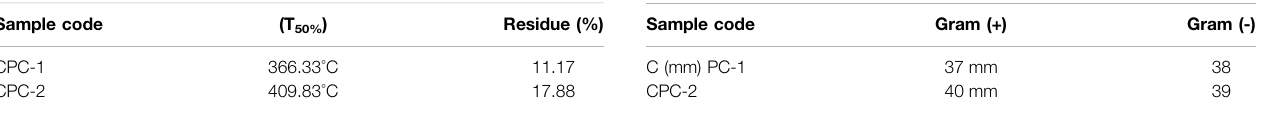
TABLE 2 | Antimicrobial results against E. coli and S. aurus